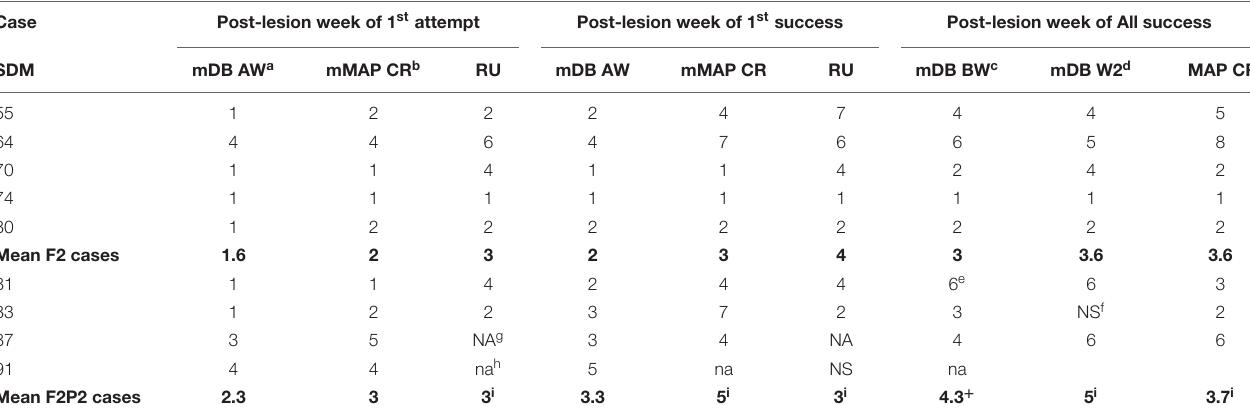
TABLE 2 | Initial recovery in the mDB, mMAP, and RU tests and manipulation skill recovery for each